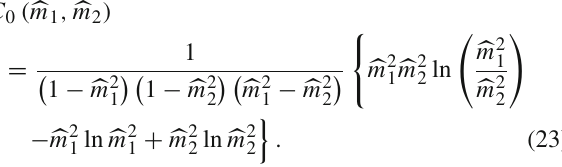
respectively at 1 σ (red), 2 σ (brown) and 3 σ 2 , 1